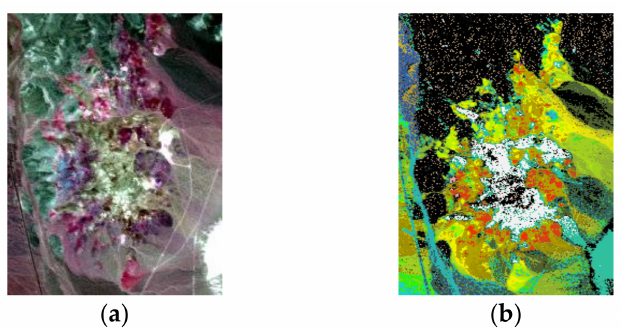
Figure 9. Sub-image of AVIRIS data. ( a ) Sub-image of AVIRIS data (R 2.10 µ m, G 2.20 µ m, B 2.34 µ m); ( b ) USGS 1995 Nevada Cuprite reference map.